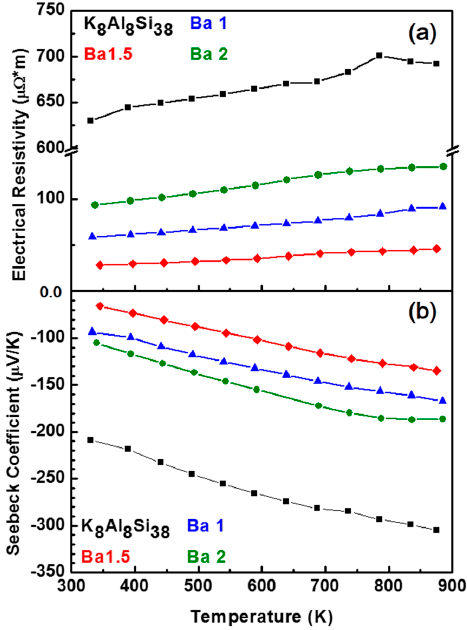
Figure 6. Temperature dependence of the ( a ) electrical resistivity and ( b ) absolute Seebeck coefficient measurements for K 8-x Ba x Al 8+x Si 38-x (x = 0, 1, 1.5, 2) samples from 323 K to 873 K. Reprinted with permission from Sui, F.; Kauzlarich, S.M. Tuning Thermoelectric Properties of Type I Clathrate K 8-x Ba x Al 8+x Si 38-x through Barium Substitution. Chem. Mat. 2016 , 28 , 3099–3107 [37]. Copyright (2016) American Chemical Society.